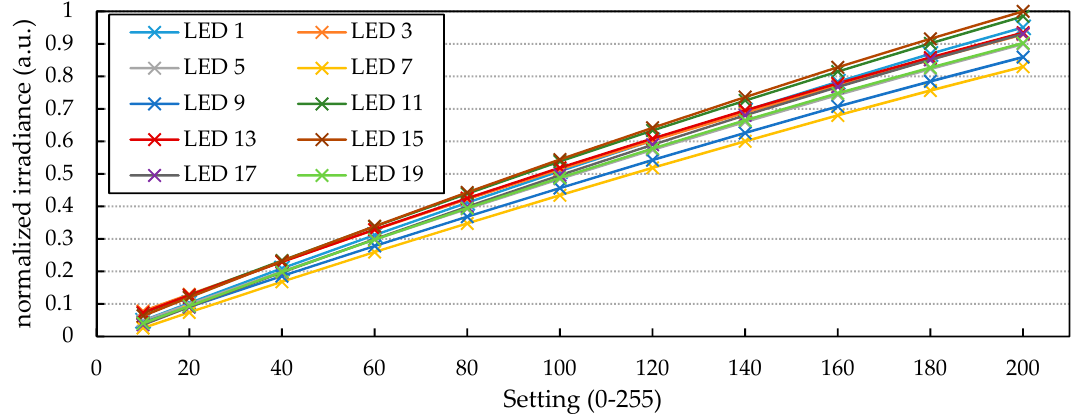
Figure 9. Radiance of 10 LEDs measured with a photodiode and an integrating sphere. The measured photodiode current is plotted against the digital setting of the LED current.